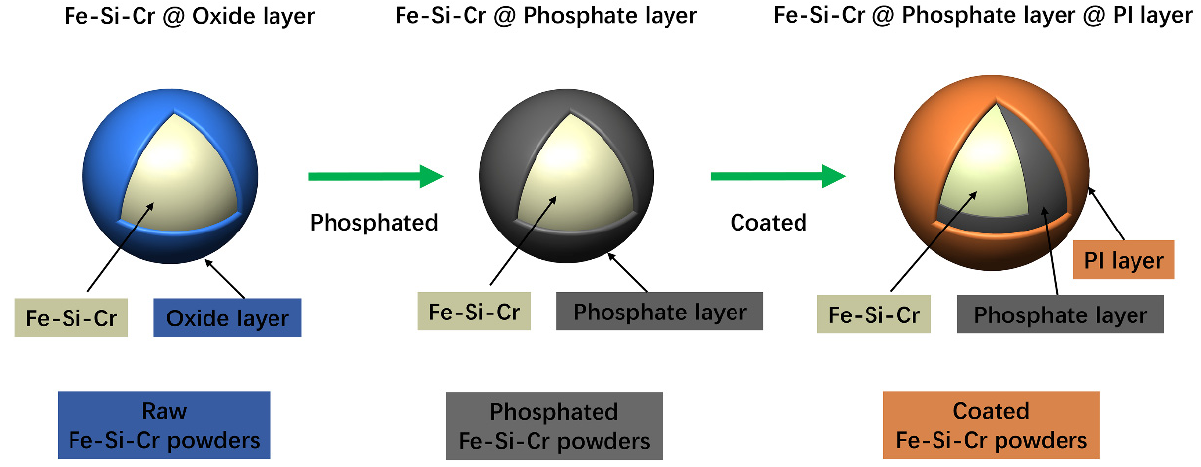
Figure 3. The effect of phosphating and coating process on the surface of Fe-Si-Cr powder particles.